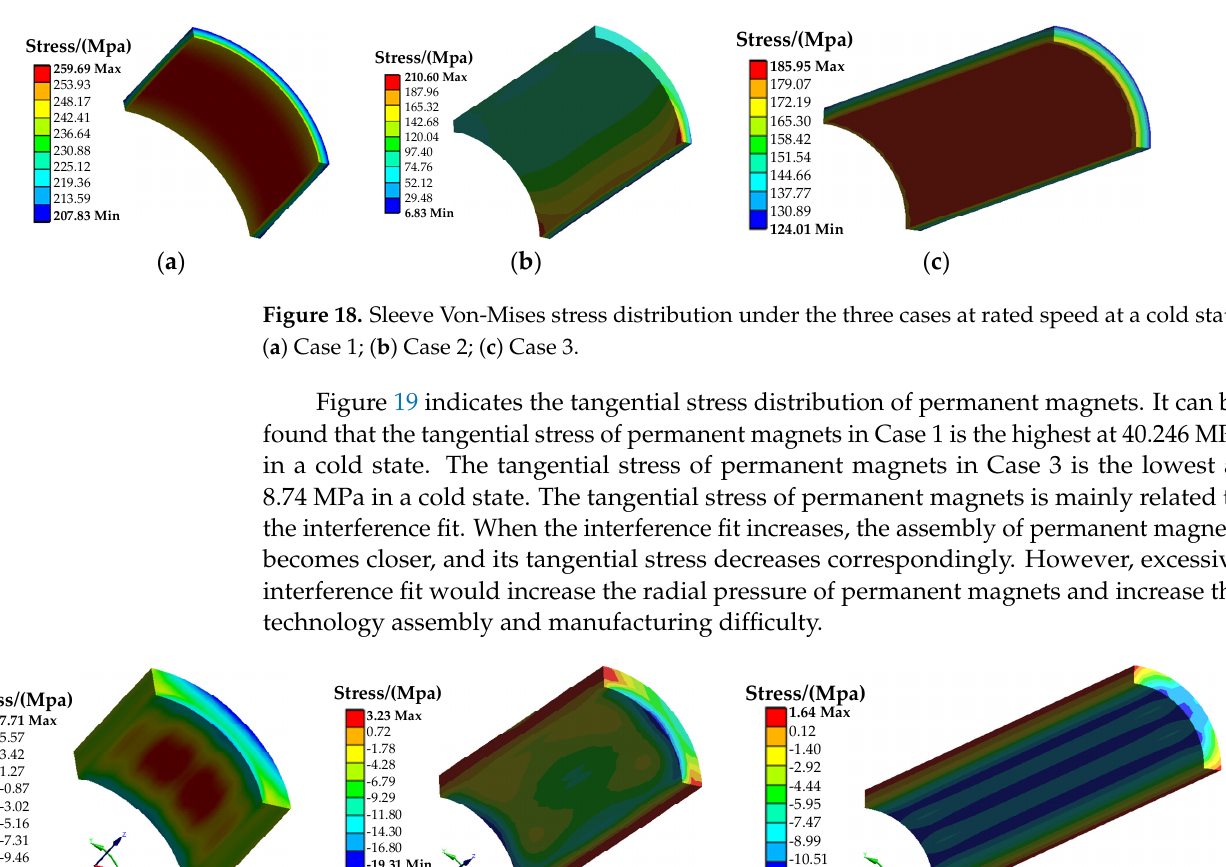
Stress/(Mpa) 334.33 Max 325.19 316.06 306.92 297.78 288.65 279.51 270.37 261.24 252.10 Min ( c ) Figure 21. Sleeve Von − Mises stress distribution under the three cases at rated speed in a hot state: ( a ) Case 1; ( b ) Case 2; ( c ) Case 3.